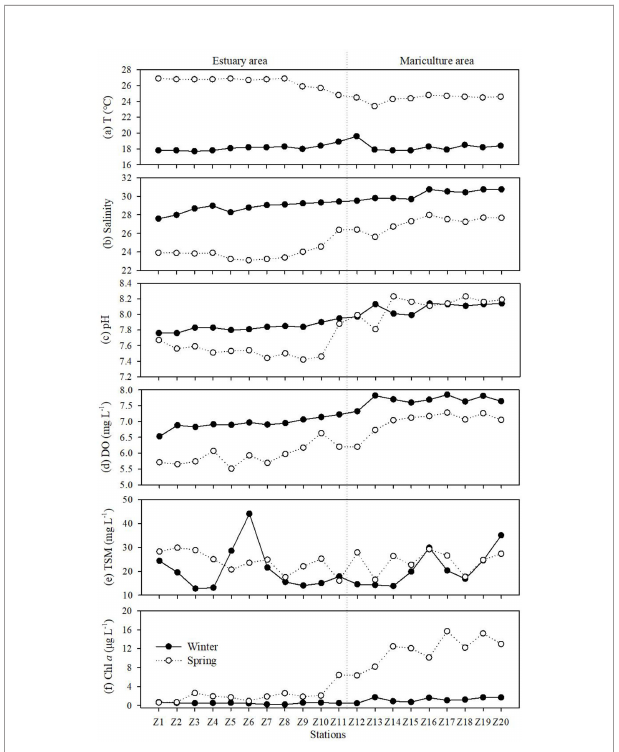
FIGURE 2 | Variations of the physico-chemical parameters in the seawater of the estuary and mariculture area in Qinzhou Bay during winter and